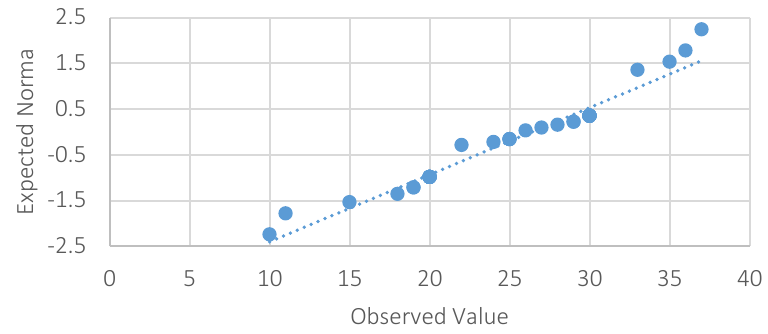
Figure 1. Normal line graph (non-brainstorming